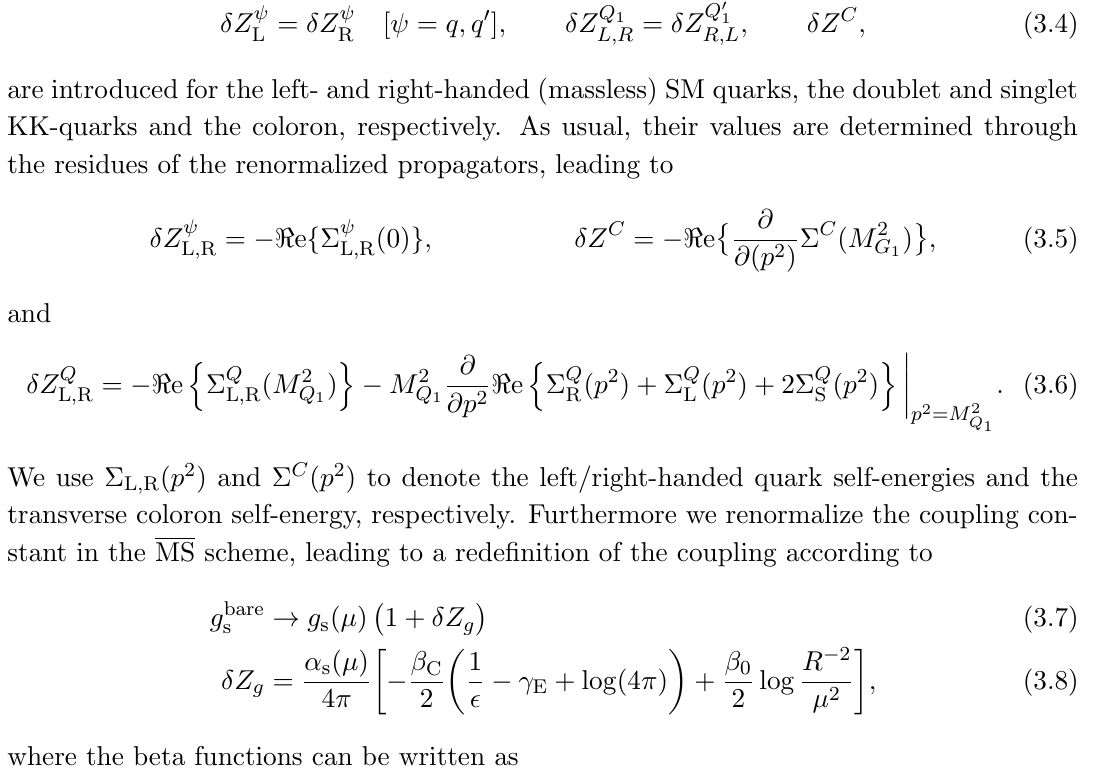
Figure 1 . Sample diagrams the decay of the level-1 gluon decay G 1 ! qQ model. (A) Born-level decay; (B) NLO correction to the born vertex; and (C) real emission contribu- tion with an infrared divergence. Here a spring-straight line, solid double line and broken double line indicate the propagator of a coloron, heavy quark, and Goldstone mode of the coloron,